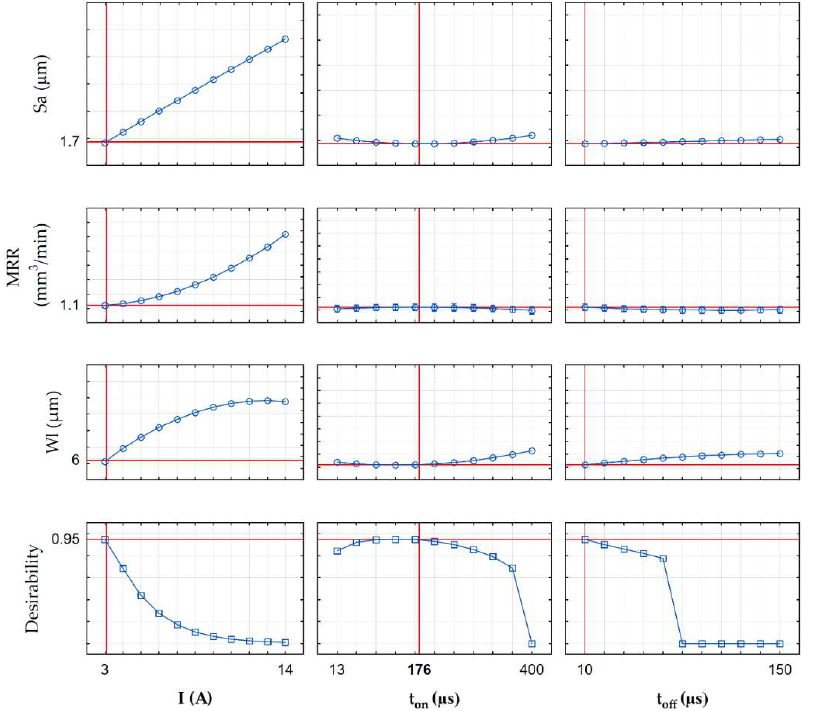
Figure 19. The example of profiles for the predicted values and desirability for the finishing EDM.